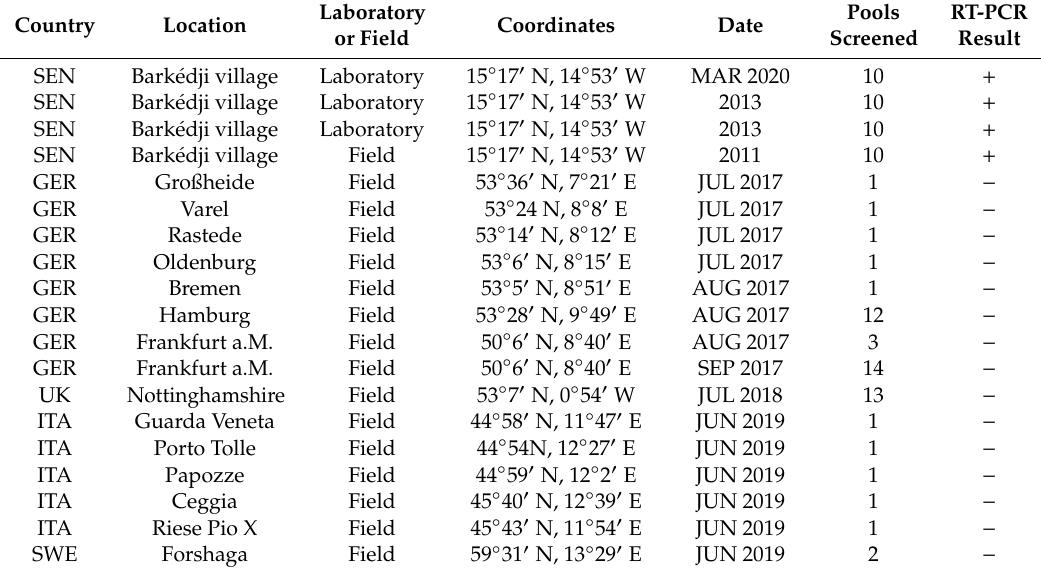
Table 1. Table listing the field or laboratory origins of Ae. vexans spp samples as well as the collection site, collection date, the number of pools screened (1–6 mosquitoes per pool), and Aedes vexans iflavirus RT-PCR positive ( + ), or negative (–) result. Countries: Senegal (SEN); Germany (GER); the United Kingdom (UK); Italy (ITA); Sweden (SWE). Calendar months: MAR (March); JUN (June); JUL (July); AUG (August); SEP (September).